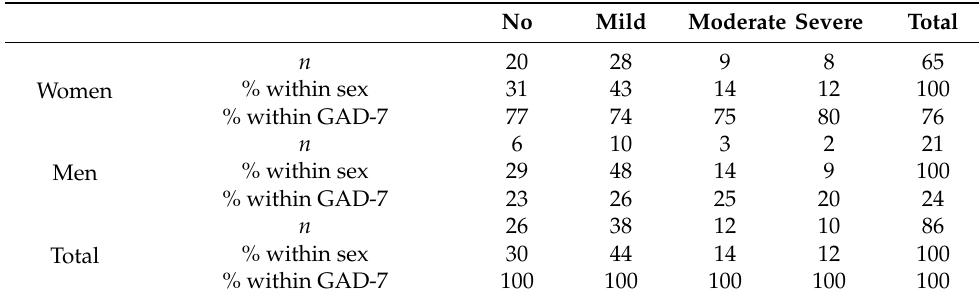
Table 1. General Anxiety Disorder scale (GAD-7) questionnaire scores according to sex of the studied population.